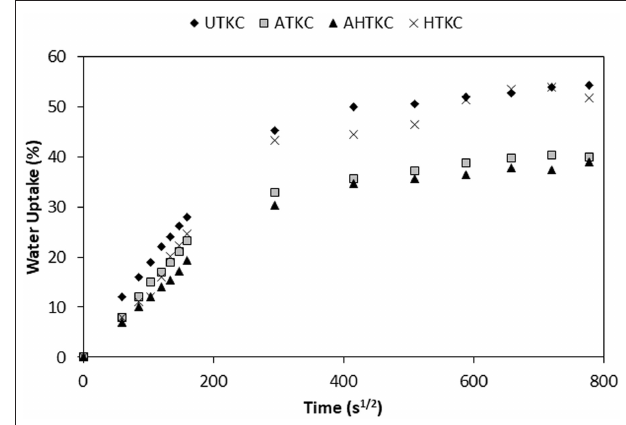
FIGURE 7 | Water absorption behavior of KF/Acrodur ®